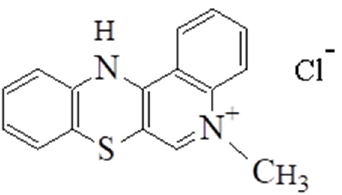
Figure 1. Figure 1. Chloride-5-methyl-12(H)-chino[3,4-b]-1,4-benzothiazine. 5-Alkyl-12(H)-quino[3,4-b] [1,4] benzothiazine salts exhibit antiproliferative proper- ties. The analyzed compound was tested in vitro for antitumor activity using two cultured cell lines: HCT 116 human colon cancer (American Type Culture Collection, Rockville, MD, USA) and lung cancer LLC (Institute of Immunology and Experimental Therapy, Wroc ł aw, Poland) using doxorubicin as a reference. The tested compound showed activity against both tumor cell lines [18]. One of the mechanisms involved in the antiproliferative activity of chemotherapeutic agents is DNA intercalation. This mode of action is typical of antiproliferative anthracy- cline antibiotics, e.g., doxorubicin. The 5-alkyl-12(H)-quino[3,4-b] [1,4] benzothiazine salts have a similar structure, thus it can be assumed that these compounds possess similar antiproliferative mechanism of action. The research has shown that the 1,4-thiazine ring is responsible for antiproliferative activity of 5-alkyl-12(H)-quino[3,4-b] [1,4] benzothia- zine salts. The compounds with substituents in the 9 and 10 position of the quinobenzo- thiazine ring and 5-methyl-12(H)-chloride have the highest antitumor activity among the 5-alkyl-12(H)-quino[3,4-b] [1,4] benzothiazines, the latter without additional substituents [18]. Obtaining the liposomal form of 5-methyl-12(H)-quino[3,4-b] [1,4] benzothiazinium chloride (5-MBT) allowed us to analyze the influence of the surrounding pH on the pro- cess of 5-MBT release from liposomes. In order to analyze more precisely the process of 5-MBT release from liposomes un- der conditions simulating an in vivo situation, the tested samples were exposed to human serum albumin (HSA). The tests were carried out at 37 °C. 2. Materials and Methods 2.1. Materials L- α -phosphatidylcholine dipalmitoyl (1,2-dihexadecanoyl- sn -glycerol-3-phospho- choline) (DPPC, purity 99%), chloroform, dichloromethane, hydrochloric acid, acetic acid 80%, acetic acid sodium salt trihydrate, disodium hydrogen phosphate, dipotassium hy- drogen phosphate, 2-(3carboxypropyl)-4,4-dimethyl-2-tridecyl-3-oxazolidinyloxyl (5- DOXYL), and α , α , α –Tris-(hydroxymethyl)-methylamin (TRIS, purity 99.9%) were pur- chased from Sigma-Aldrich, Schnelldorf, Germany. Human serum albumin (HSA) frac- tion V, crystallized and lyophilized, was purchased from MP Biomedicals, France. Chlo- ride-5-methyl-12(H)-quino[3,4-b]-1,4-benzothiazine (5-MBT) was synthesized at the De- partment of Organic Chemistry, Medical University of Silesia in Katowice. 2.2. Methods 2.2.1. The Synthesis of 5-Methyl-12(H)-quino[3,4-b] [1,4] Benzothiazine Chloride 12 (H)-quino[3,4-b] [1,4] benzothiazine salts are formed by the reaction of 5,12- (di- methyl) thiquinanthrenedium bischloride with aromatic amines. The structure of the re- action products depends on the presence of oxygen in the reaction mixture. If the reaction of the bis-chloride with aromatic amines is carried out in the presence of atmospheric ox- ygen with vigorous stirring, the reaction products are the corresponding 12 (H)-quino[3,4- b] [1,4] benzothiazine salts. When the reaction is carried out in the absence of atmospheric oxygen, the reaction gives 1-alkyl-4- (arylamino) quinoline-3-thiolanes. In the presence of